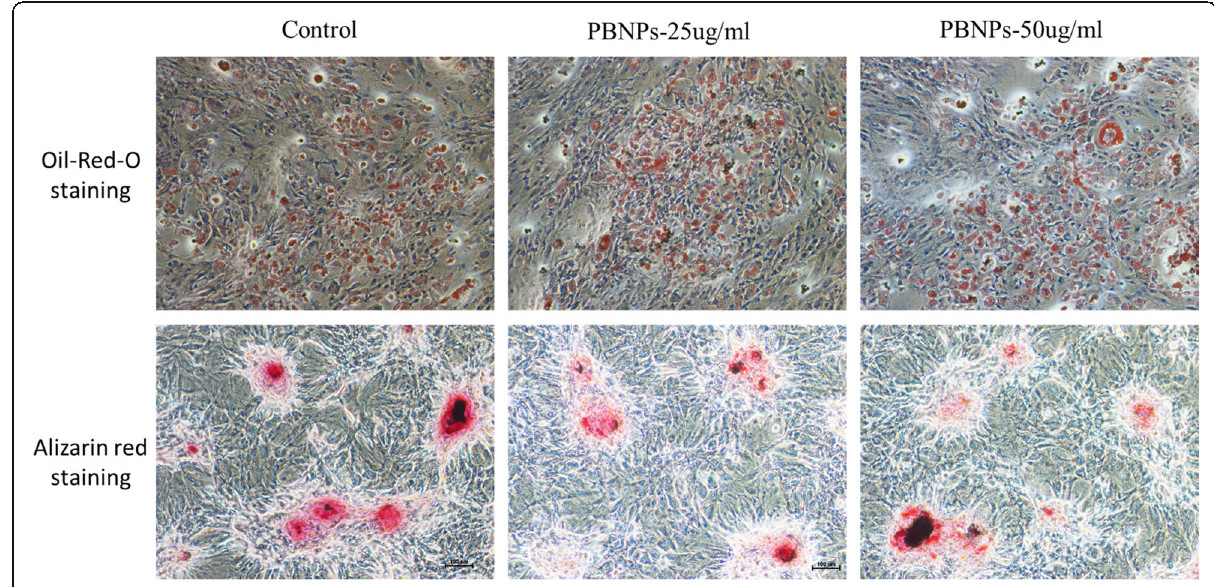
Fig. 6 In vitro cell differentiation of cells with or without PBNPs. Oil Red O staining for adipocyte and Alizarin Red staining for osteocytes. Images were obtained 3 weeks after labeling (magnification × 200)